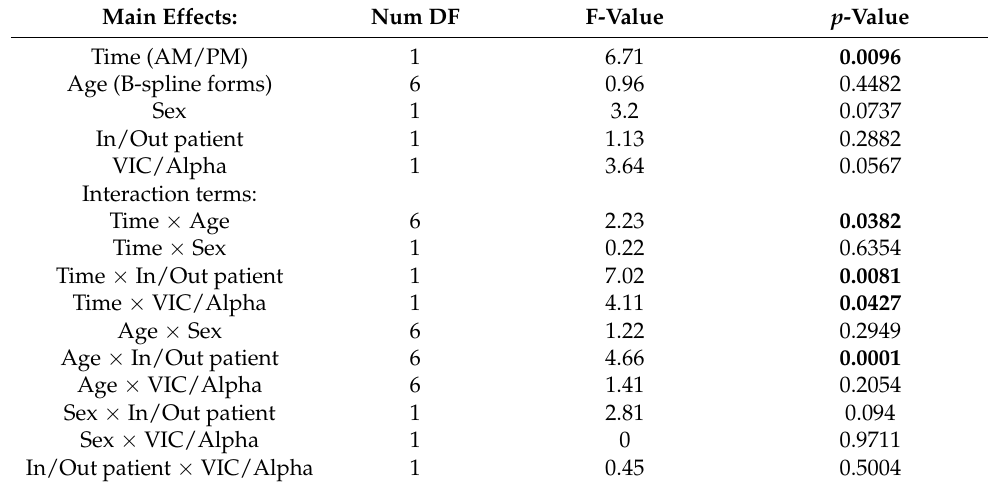
Table 4. Analyses with age as a continuous